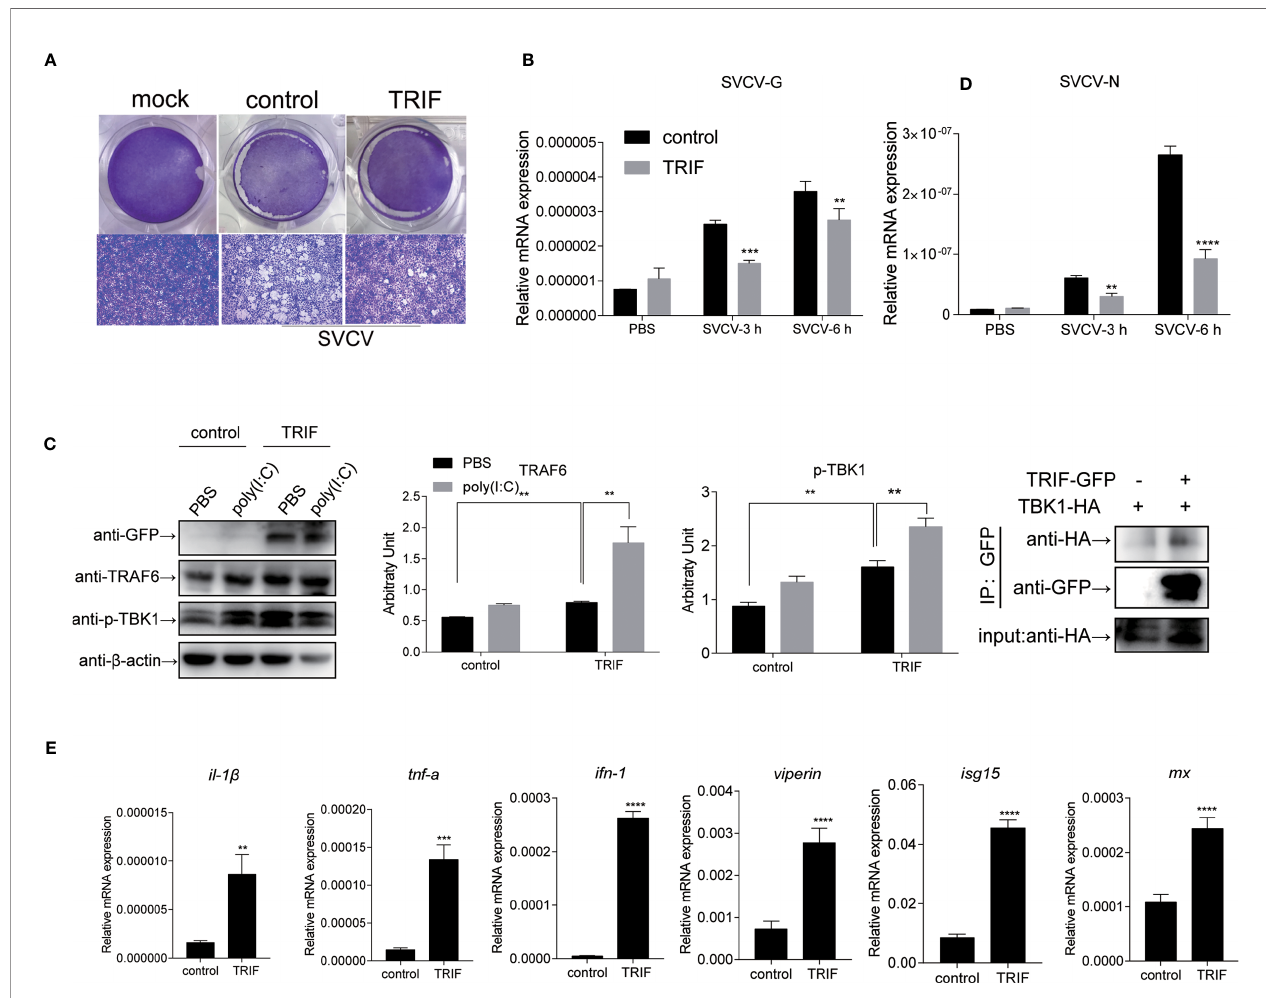
FIGURE 8 | Carp TRIF involved in the antiviral response via the TRAF6-TBK1 axis. (A) EPC cells were seeded in 24-well plated overnight and transfected with pEGFP-N1 (control) or carp TRIF-EGFP. At 24 h post-transfection, the cells were infected with SVCV (MOI = 0.01) per well and incubated at 25°C for 24 h. This experiment was divided into two groups. (A) One group of cells stained with crystal violet for CPE. The cell monolayers were stained with crystal violet, and CPE was observed. (B) The second group of cells was used to extract the total RNA. The expression levels of SVCV-G and SVCV-N transcripts of SVCV by qRT-PCR analysis. (C) Cells were transiently transfected with above-mentioned plasmids in six-well plates. After 24 h of transfection, poly(I:C) stimulation was administered for 24 h, and then immunoblotted was conducted with the indicated antibodies. b -actin was used as a loading control. TRAF6/ b -actin and p-TBK1/ b -actin levels were quanti fi ed by the Image J software. (D) 293T cells were transfected with the indicated plasmids. At 48 h post-transfection, cell lysates were immunoprecipitated with anti-GFP, and immunoblotted analyzed with the indicated Abs. (E) EPC cells were transiently transfected with the indicated plasmids and harvested to quantify the relative expression levels of IFN-stimulated genes and proin fl ammatory genes at 6 h post SVCV infection. The results were calculated relative to the expression of EF- 1 a . All experiments were repeated at least three times with similar results. ** P < 0.01, *** P < 0.001, **** P <